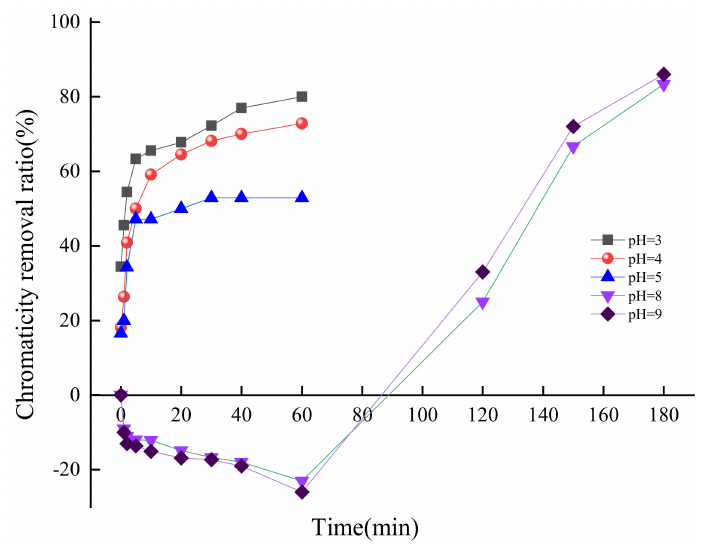
Figure 5. Effect of pH value on chromaticity removal from simulated